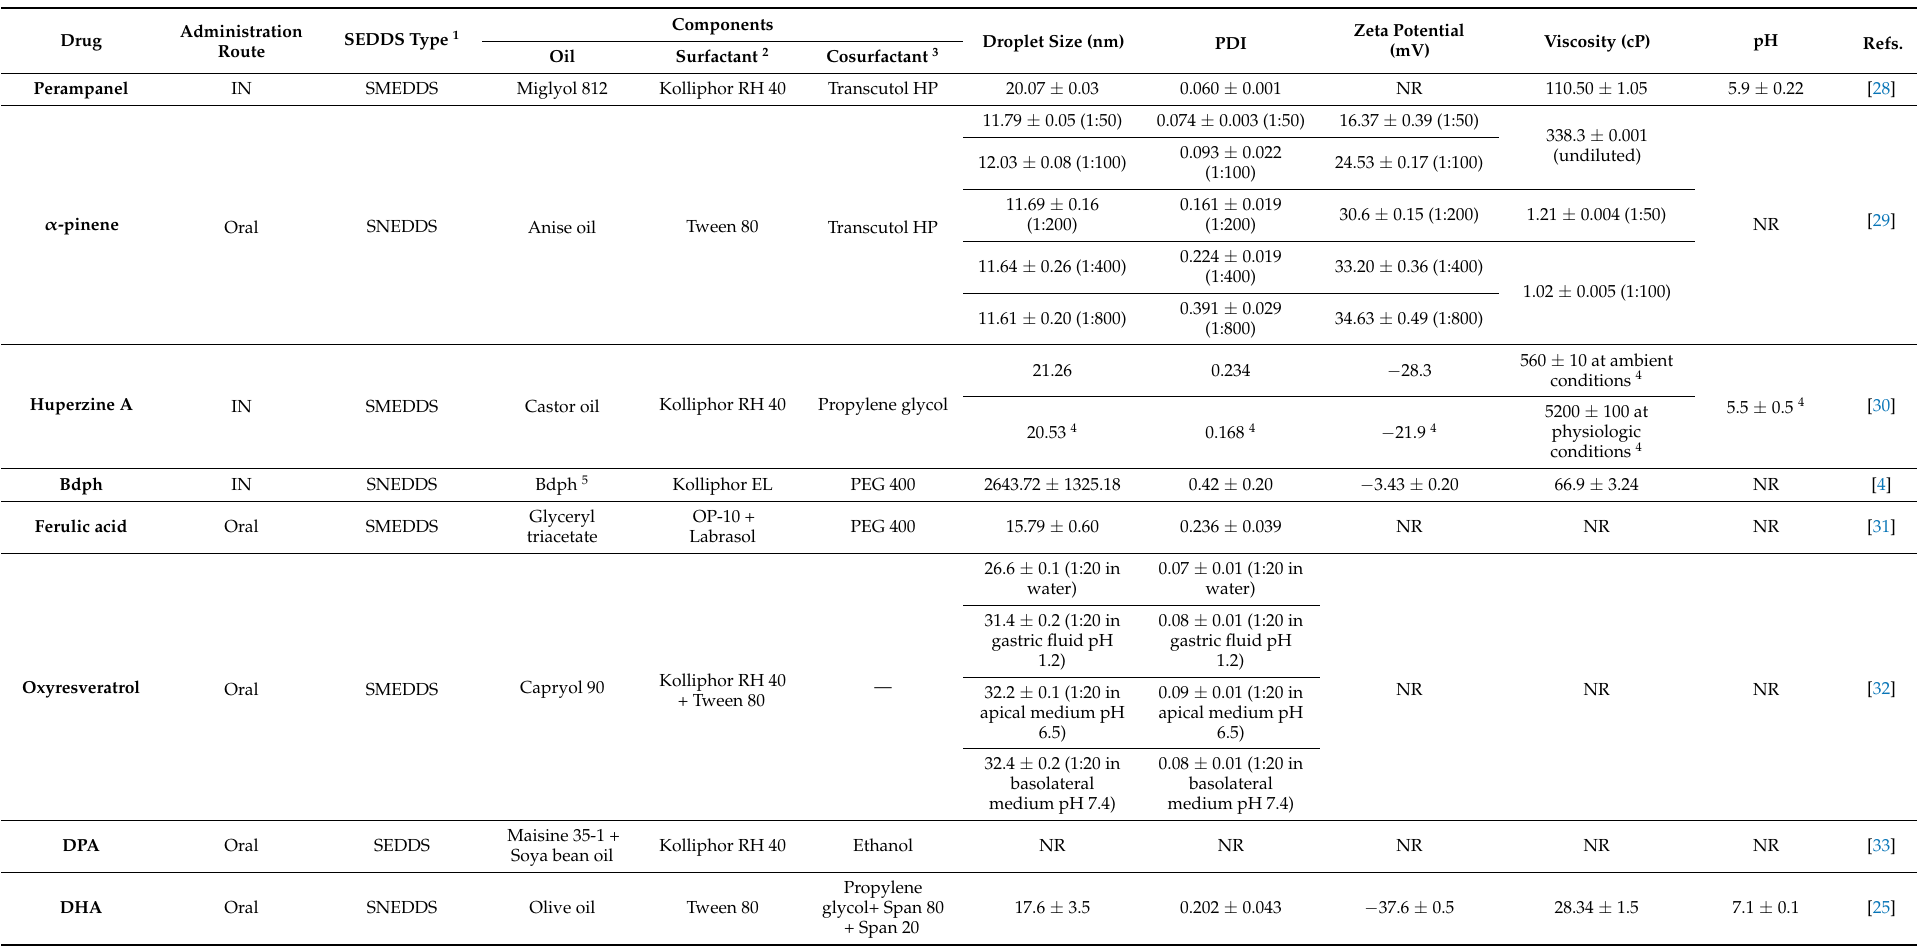
Table 1. Composition and main physicochemical characteristics of self-emulsifying drug delivery systems (SEDDS) investigated for brain delivery of neu- rotherapeutics by intranasal (IN), intravenous (IV) or oral routes. The methodology used for data collection is summarized in Figure S1 of the Supplementary